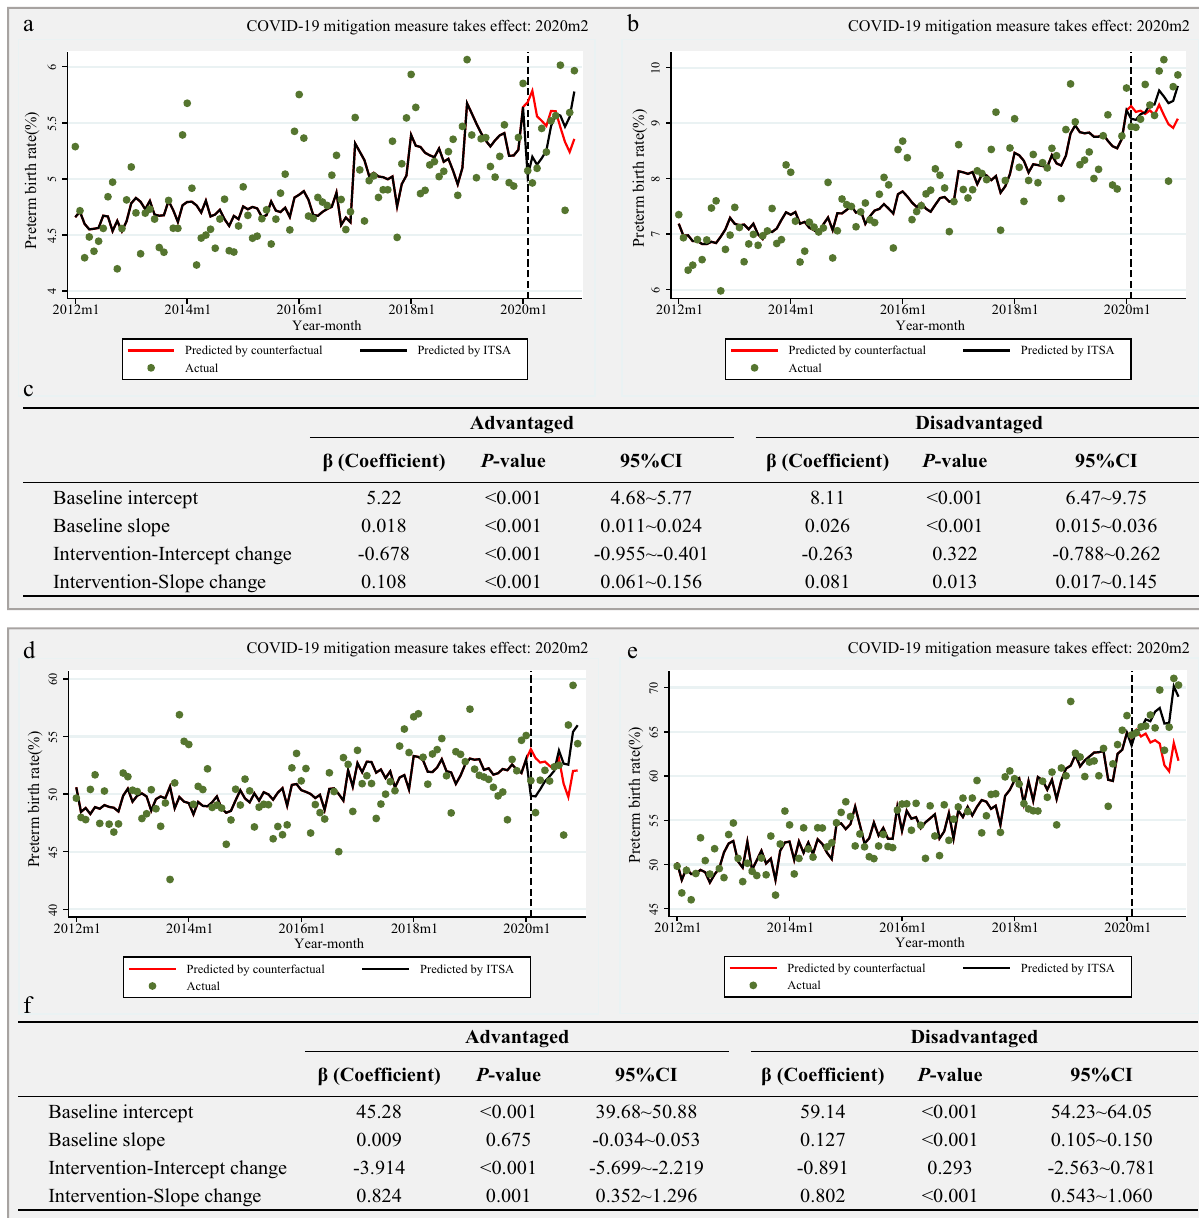
Fig. 2 | Interrupted time series analysis (ITSA) of the preterm birth rate across different socioeconomic statuses in China, 2012 – 2020. a advantaged in single- ton births; b disadvantaged in singleton births; c the result of ITSA in singleton births across population; d advantaged in mutiple births; e disadvantaged in mutiple births; f the result of ITSA in multiple births across population. Dots indi- catetruemonthlypretermbirthratesandsolidlinesindicatethemeanofestimated pretermbirthratespermonthbyITSAmodel,andredsolidlinesindicatethemean of estimated preterm birth rates per month assuming that COVID-19 mitigation measure had not occurred by ordinary least-squares regression with Newey-West